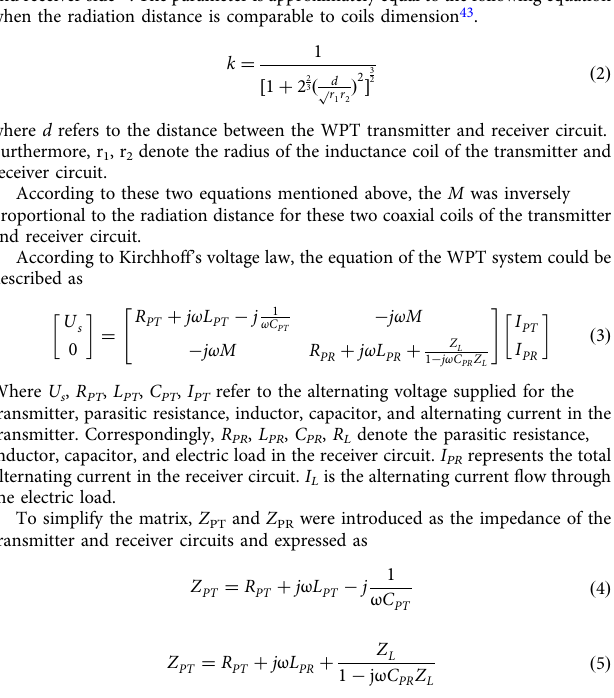
Fig. 6 Sensing and therapeutic performance of the integrated WTCL. a Quantitative analysis of ex vivo rhodamine B released from WTCL at different alternating voltages for 30 min. N = 6 measurements at each time point. b Rhodamine B was utilized as the medicine analog in ex vivo experiments